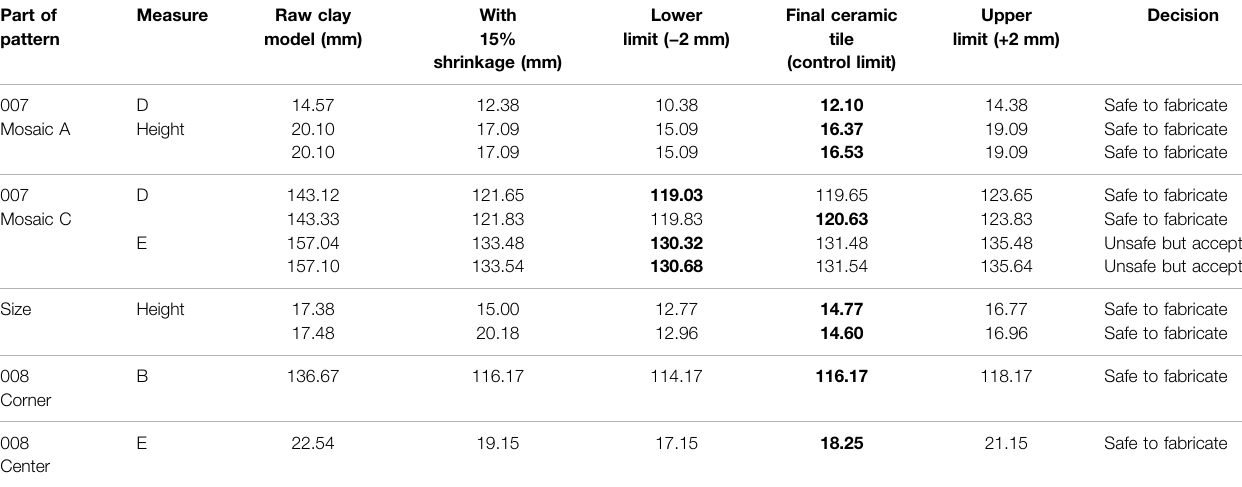
TABLE 1 | Validation of measurements and established tolerances of wall tiles with shrinkage greater than 15%. Part of